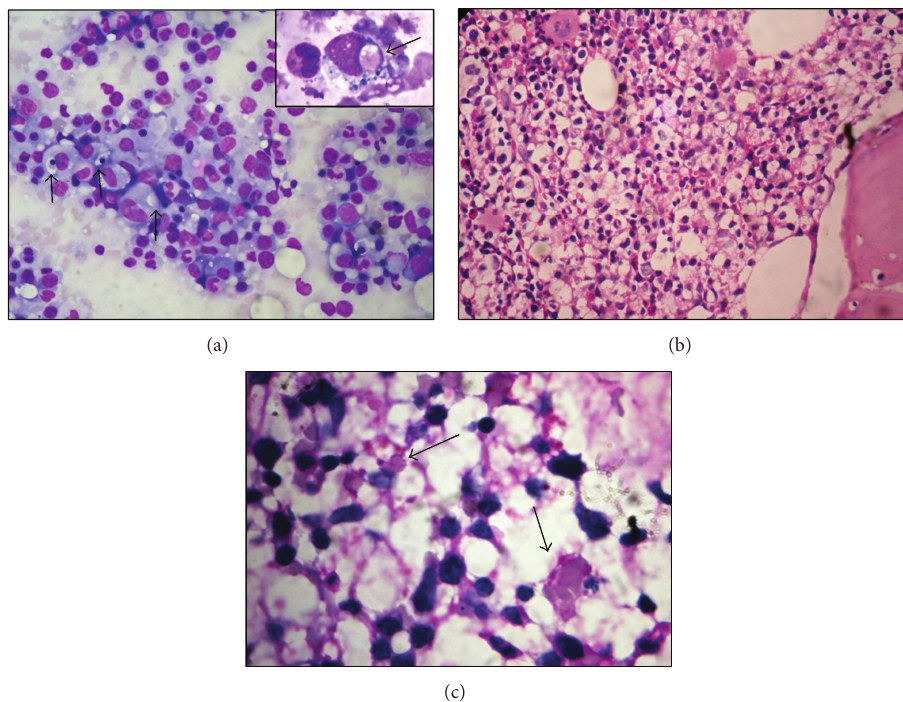
Figure 2: Bone marrow aspirate smear (a) showing hypercellularity and increased population of benign histiocytes with evidence of haemophagocytosis (black arrows, 200x). Note the evidence of erythrophagocytosis by the histiocytes (inbox, black arrow, 400x) (May Grunewald Giemsa stain). Bone marrow trephine biopsy section showing increased population of benign histiocytes in the intertrabecular marrow space (b, haematoxylin eosin, 200x). These histiocytes showed engulfed debris and obvious erythrophagocytosis (c, black arrow) (haematoxylin eosin, 400x).